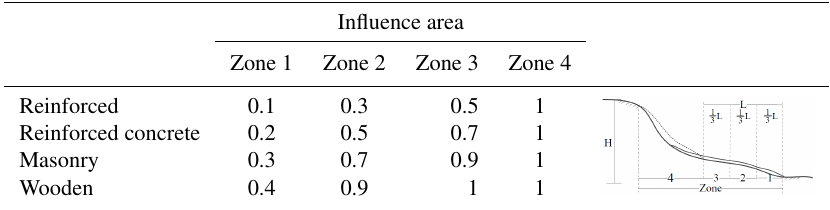
Table 4. Vulnerability value of buildings impacted by landslides (proposed by